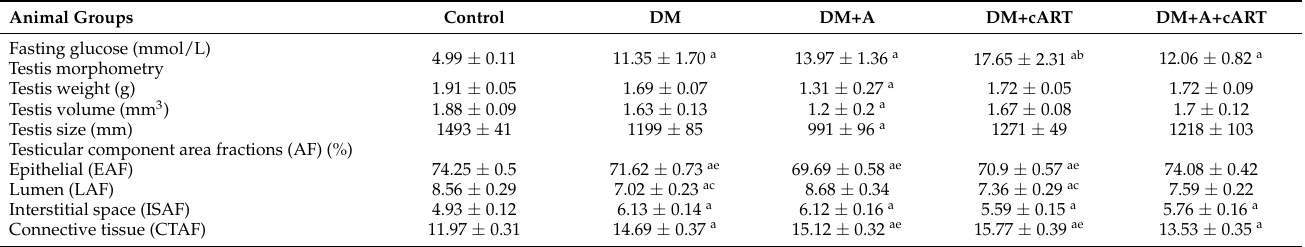
Table 1. Mean ± SEM fasting glucose, testis morphometry, and component area fractions of the animal